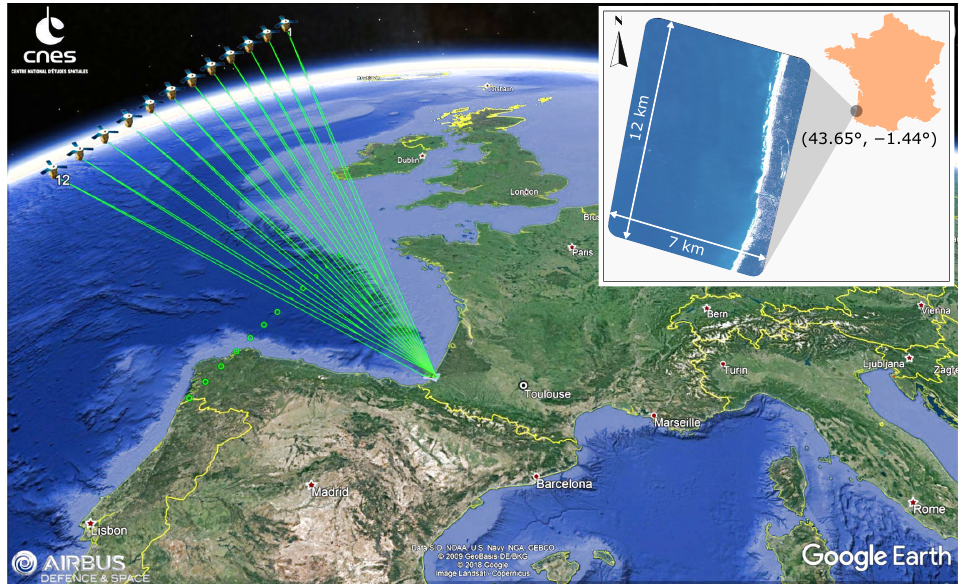
Figure 1. Pleiades satellite collecting 12 images of the field-site Capbreton, France. The observed area and its location (Lat°, Lon°) are depicted in the top